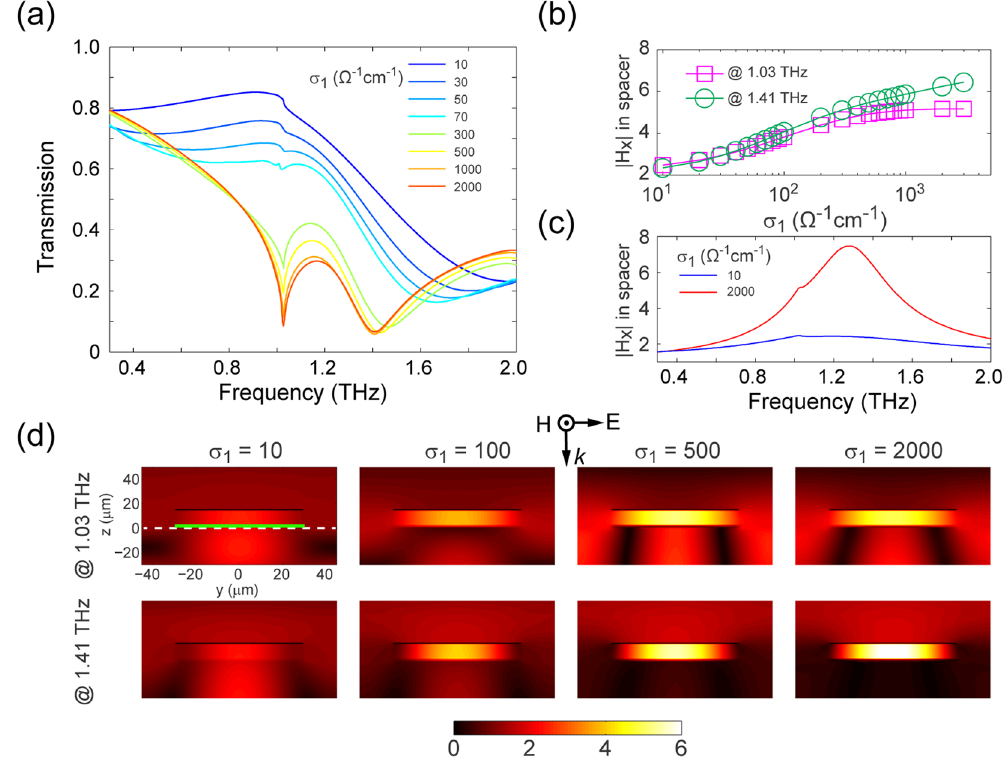
Figure 5. Au/VO 2 paired-strip based active magnetic THz metamaterial. ( a ) Simulated transmission spectra. ( b ) The x -component of magnetic field (|H x |) at the geometric center of the spacer as a function of σ 1 . ( c ) The dispersion of (|H x |) when σ 1 = 10 and 2000 Ω − 1 cm − 1 . ( d ) The distribution of magnetic field at the two resonances ( i . e ., 1.03 and 1.41 THz) for a series of σ 1 values. The white dashed line indicates the surface of the substrate and the green line represents the VO 2 film. All field data was normalized to the magnetic field magnitude of the incident